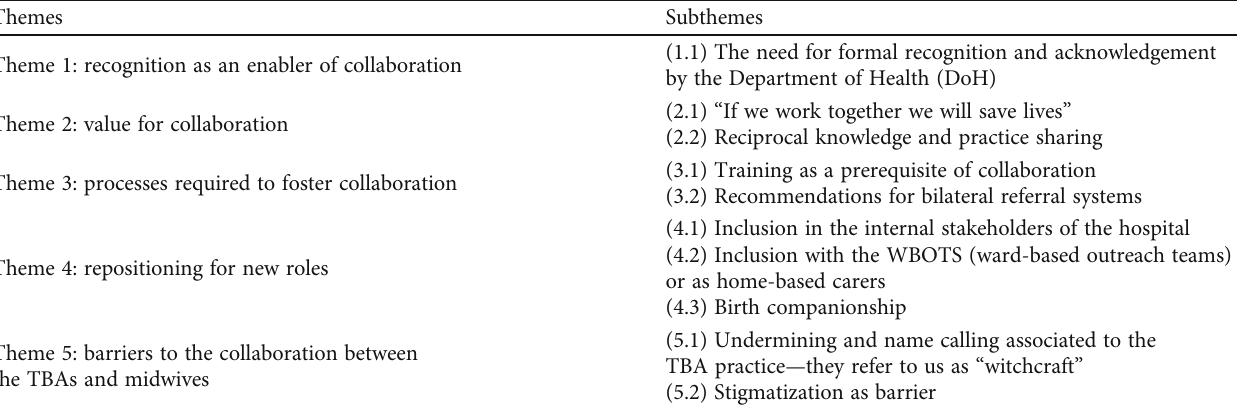
Table 1: Themes and